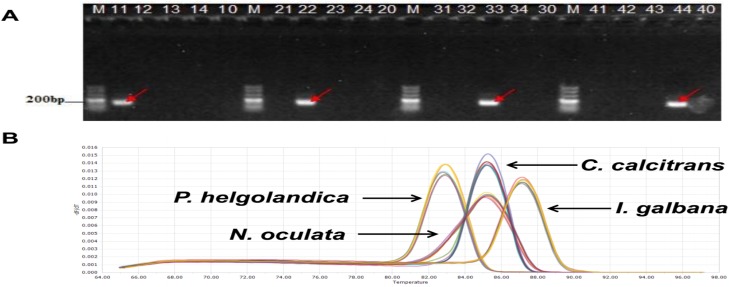
Specificity of the 18S rDNA targeted qPCR primers.(A) PCR products. Lane designations are as follows: M, DNA marker; lanes 10–14, C. calcitrans primer + no DNA, C. calcitrans DNA, I. galbana DNA, P. helgolandica DNA, N. oculata DNA; lanes 20–24, I. galbana primer + no DNA, C. calcitrans DNA, I. galbana DNA, P. helgolandica DNA, N. oculata DNA; lanes 30–34, P. helgolandica primer + no DNA, C. calcitrans DNA, I. galbana DNA, P. helgolandica DNA, N. oculata DNA; lanes 40–44, N. oculata primer + no DNA, C. calcitrans DNA, I. galbana DNA, P. helgolandica DNA, N. oculata DNA; (B) Melting curve analysis of each qPCR product. The peaks show the melting point of amplified DNA from four microalgal species. The Y-axis is the rate of change of the relative fluorescence units with time (-dF/dT), and the temperature (°C) is indicated on the X-axis.